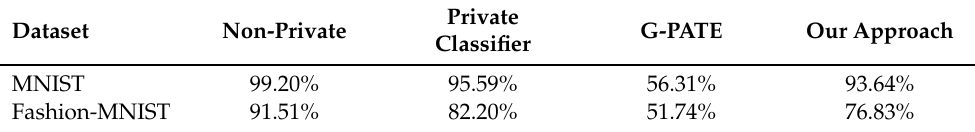
Table 1. Accuracy of models: (1) non-private baseline (convolutional network); (2) private classifier (convolutional network trained with BDP); and student models: (3) for G-PATE with ( 1,10 − 5 ) -DP guarantee; (4) for WGAN with ( 1,10 − 10 ) -BDP guarantee (our method). Private Dataset Non-Private G-PATE Our Approach Classifier MNIST 99.20% 95.59% 56.31% 93.64% Fashion-MNIST 91.51% 82.20% 51.74%